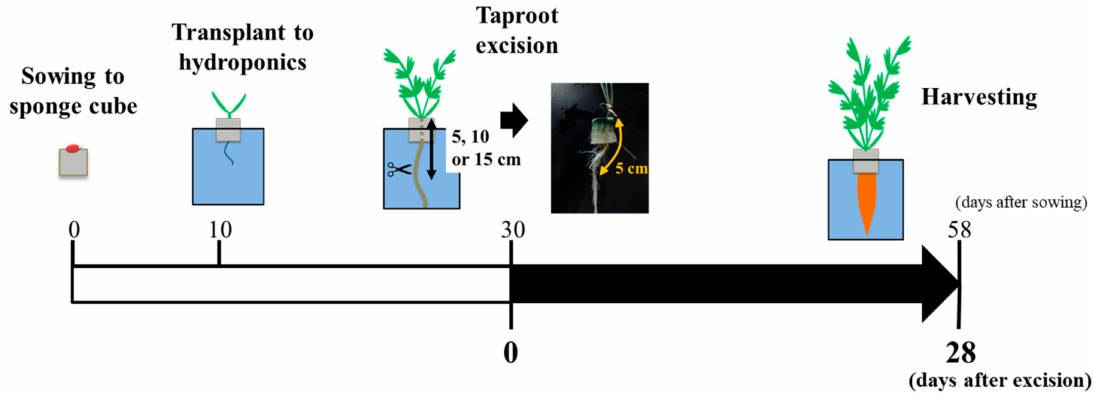
Figure 1. Experimental timeline in this